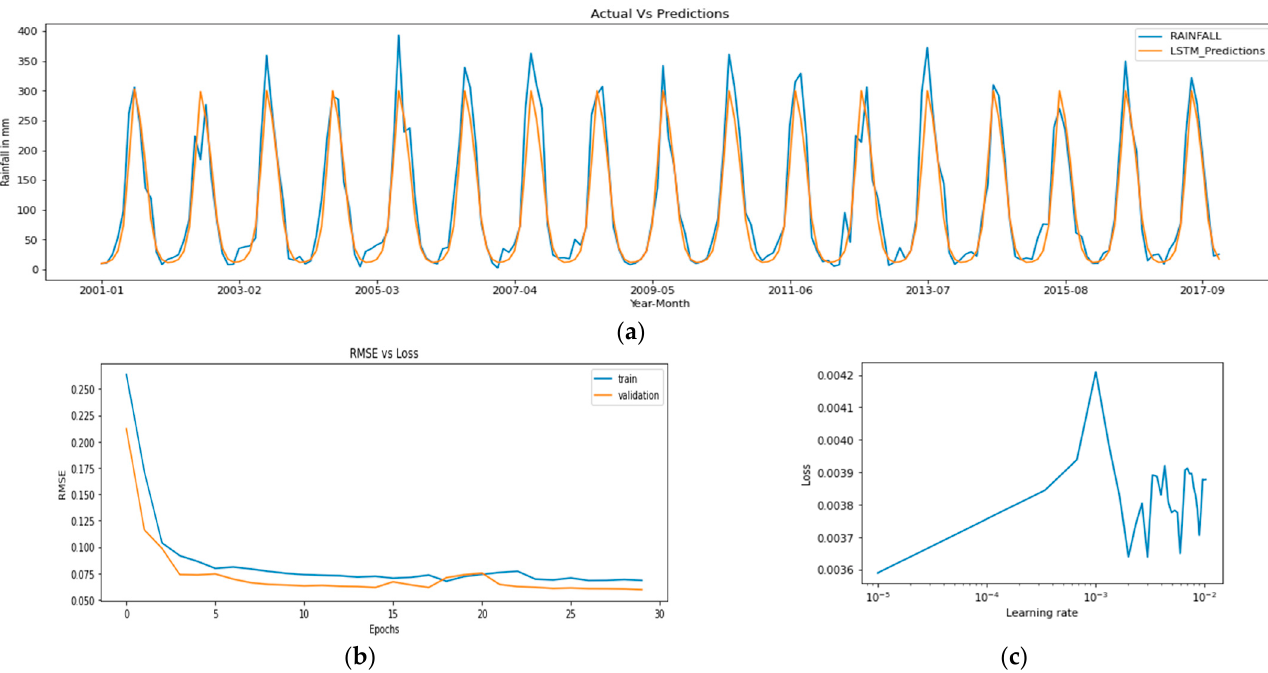
Figure 9. Performance analysis of LSTM model for rainfall forecast from the year 2001 to 2017. ( a ) Comparison of monthly actual rainfall and forecasted rainfall. ( b ) RMSE for training and test data. ( c ) Learning rate and network loss.